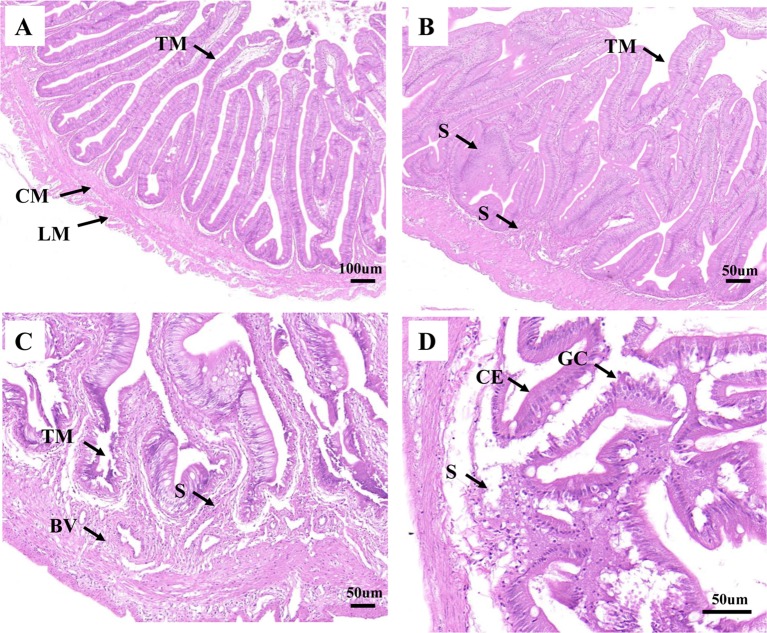
Analysis of histopathological data. (A), (B), (C), and (D) represent the intestines from H0, H2, H8, and H12 time point, respectively. BV, blood vessel; CE, columnar epithelial cell; CM, circular muscularis; GC, goblet cell; LM, longitudinal muscularis; S, submucosa; TM, tunica mucosa. The scale bar in (A) is 100 µm. The scale bar in (B), (C), and (D) is 50 µm.